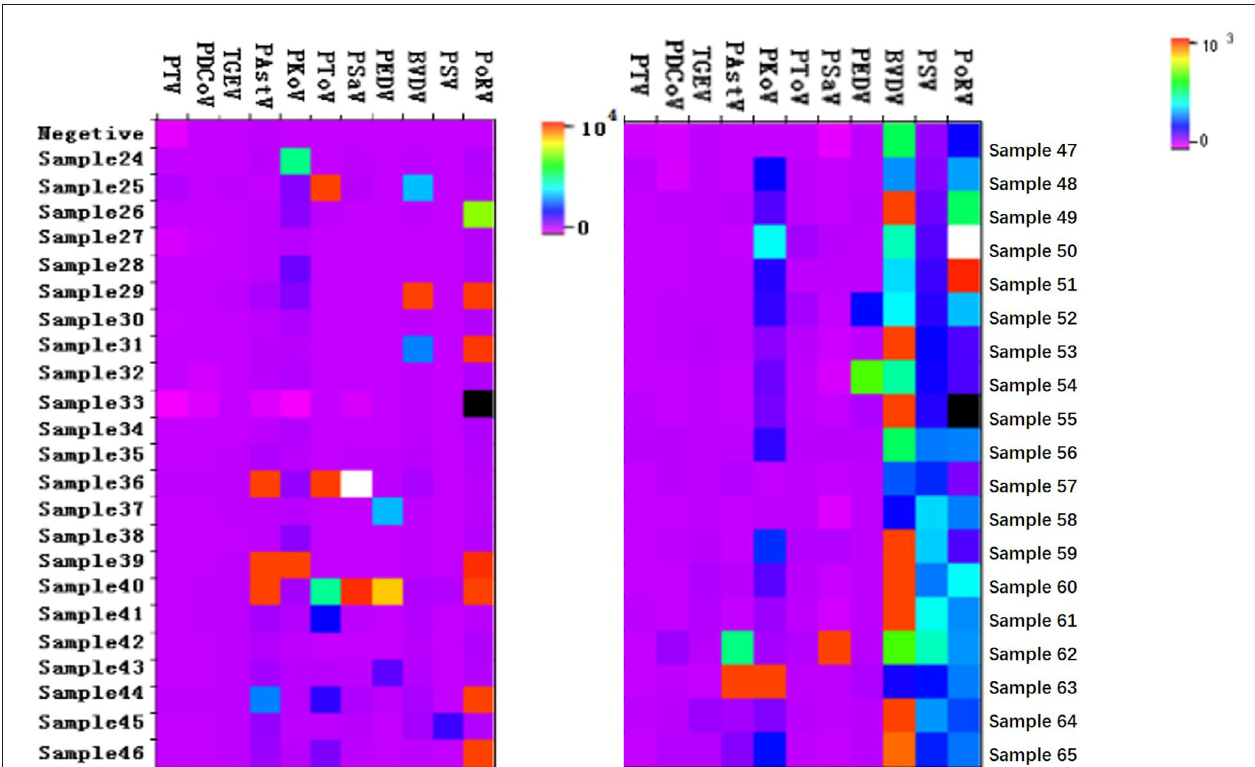
FIGURE 2 | The Heatmap for quantitative results of some samples. The porcine stool specimens were tested by the Luminex xTAG multiplex detection method. Only part data were present in the